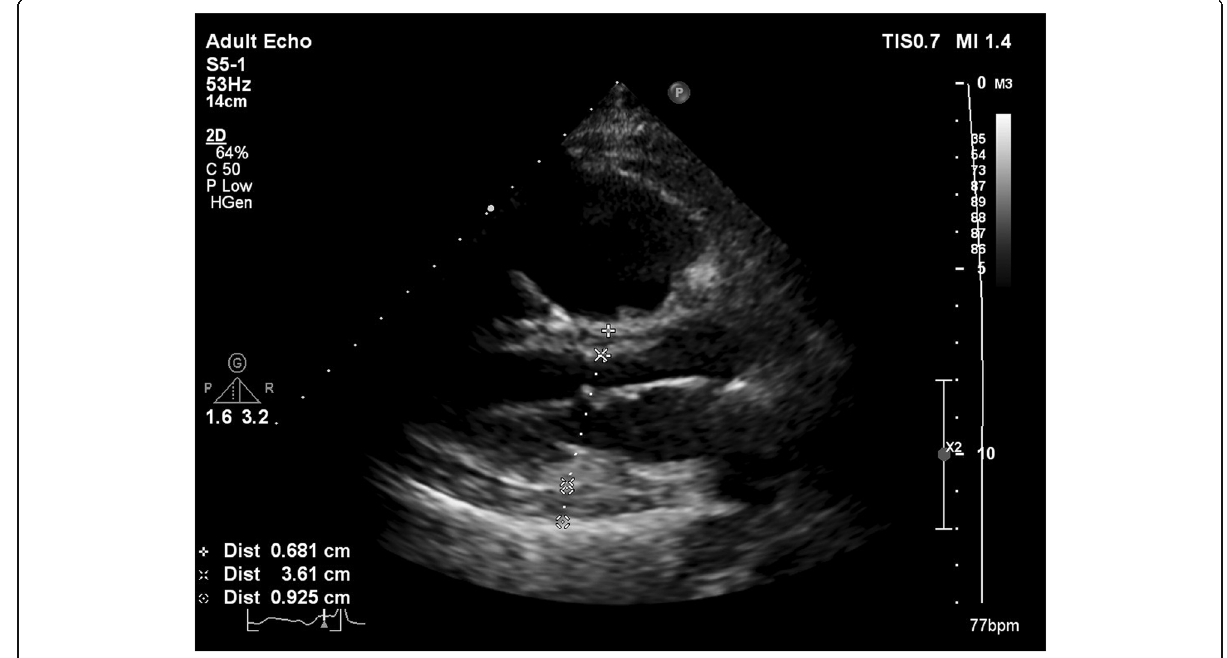
Fig. 1 Parasternal long axis TTE view showed mild pericardial effusion in the first